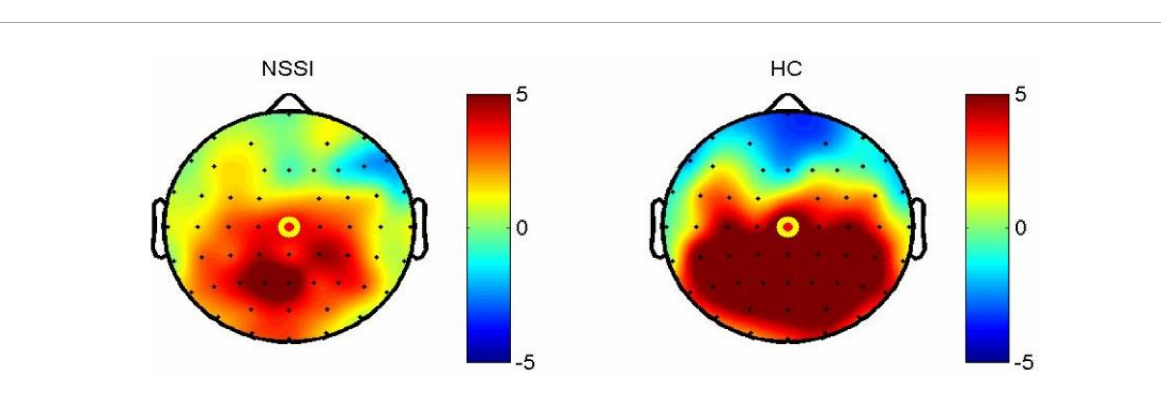
FIGURE2 Topographic map of P300 in CZ channel 200–500 ms; NSSI, non-suicidal self-injury ( n = 62); HC, healthy control ( n =